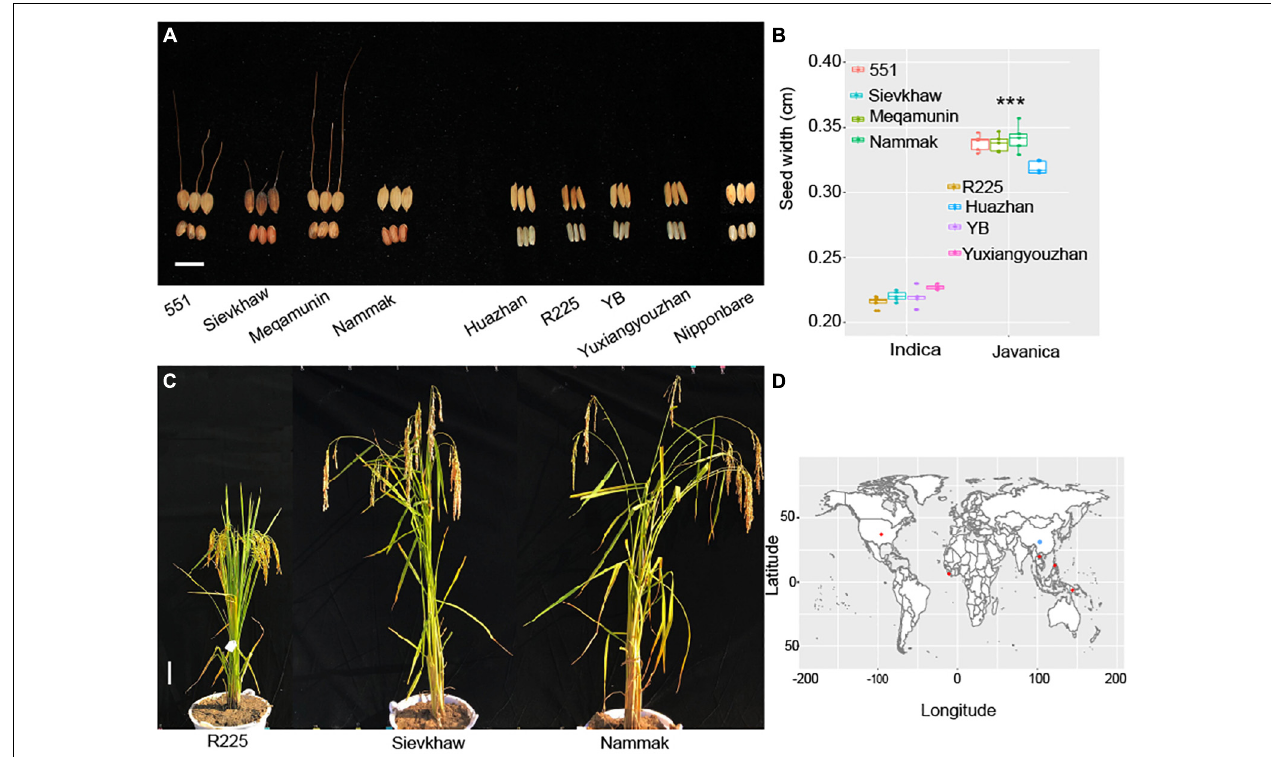
FIGURE 1 | Phenotyping of the representative Oryza javanica and the source information. (A) Grain width of four Oryza javanica and four Oryz a indica, Nipponbare was used as control. (B) Boxplot of the grain width of two subspecies. *** p < 0.001. (C) The plant performance of Super indica rice R225 and two javanica varieties. (D) The world distribution of the 20 sequenced rice accession. Red color indicates the javanica accessions, blue color shows the indica rice